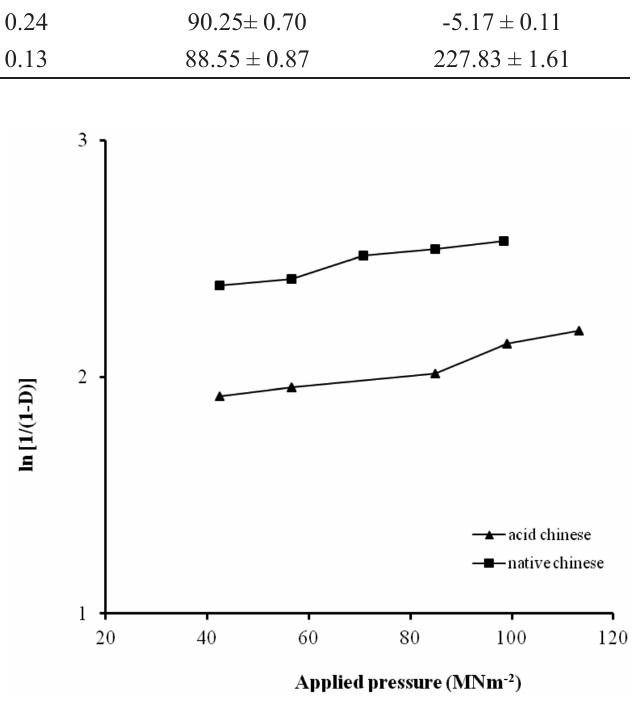
FIGURE 2 - Heckel plots for TABLE III - Parameters derived from density measurements and from the Heckel and Kawakita plots